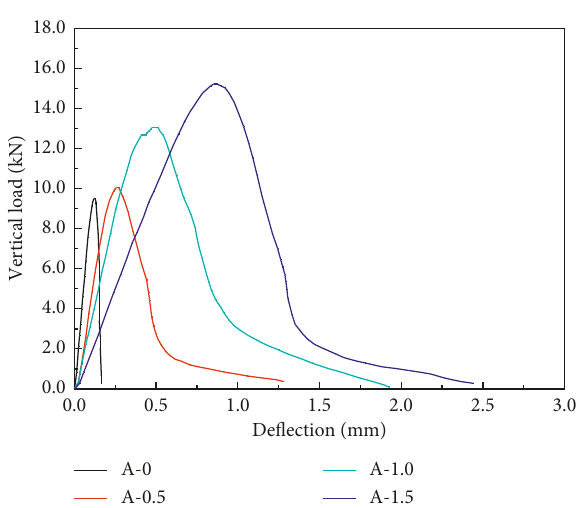
Figure 10: Relationship between vertical load and